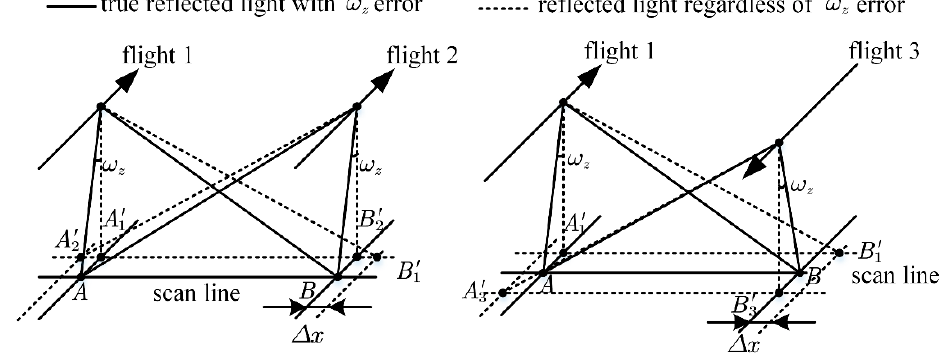
Figure 11. Schematic diagram of the simulated flights and scanned objects.